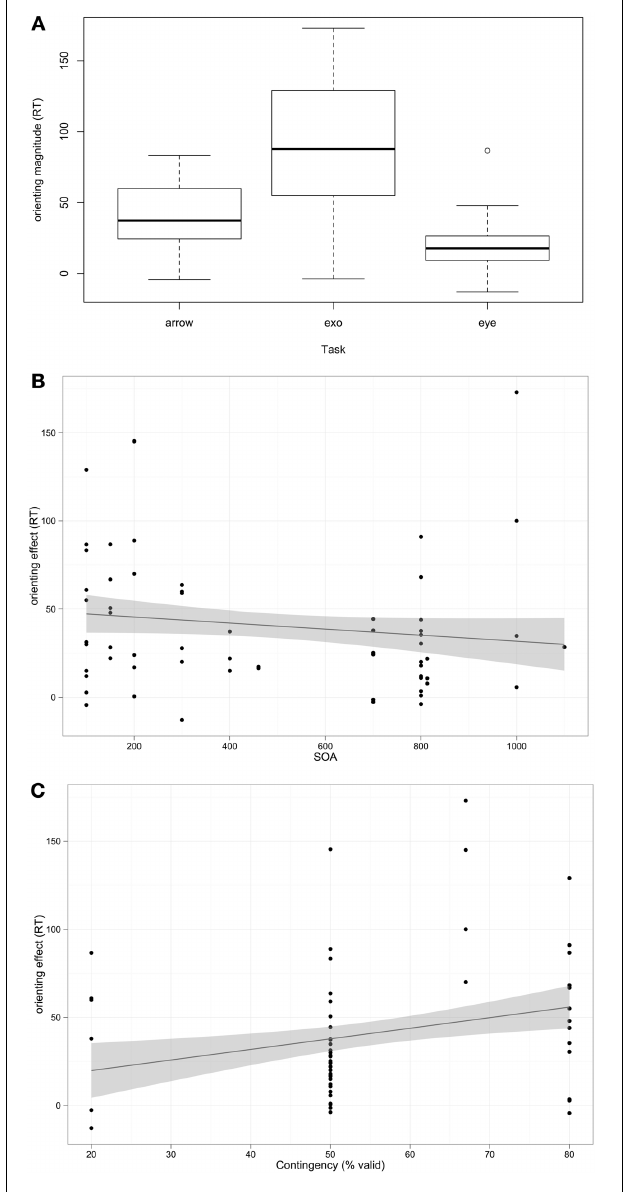
FIGURE 2 | Association between predictors and Cohen’s d effect size. (A) Box-plot of Cohen’s d -values across task types. (B,C) Scatterplots with linear regression line of best